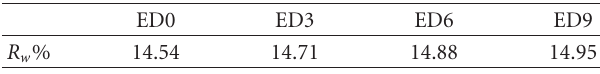
Table 1: The R w % comparison of di ff erent etching depths.